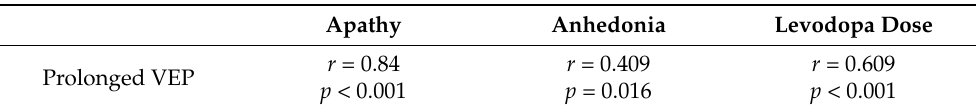
Table 3. Correlations between prolonged visual evoked potentials and presence of apa- thy/anhedonia/levodopa dose. Apathy